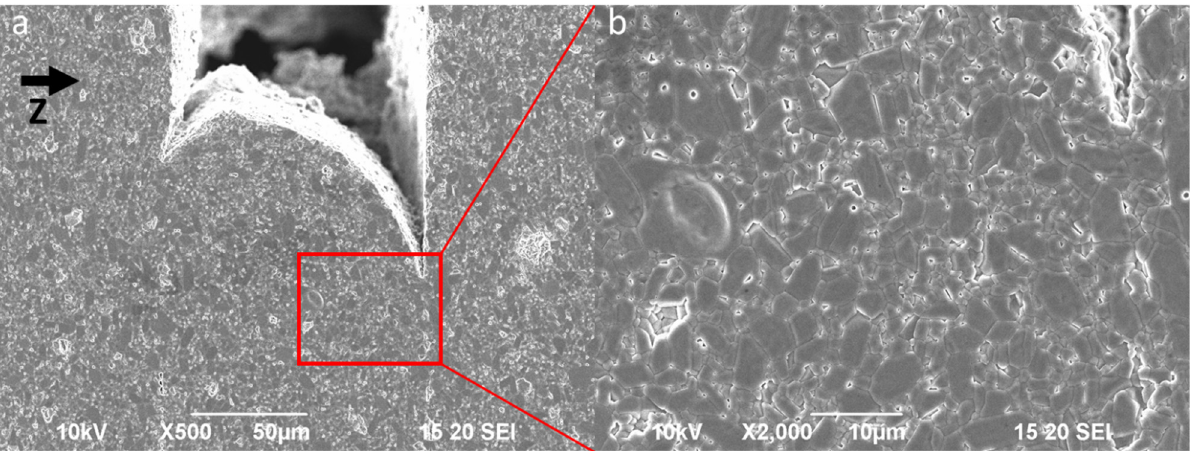
Figure 12. SEM micrographs of the cross-section of a V3 sample after sintering at 1550 °C for 120 min and thermal etching at 1300 °C for 10 min. at mag. ×500 ( a ) and mag. ×2000 ( b ), Z: vertical printing direction.